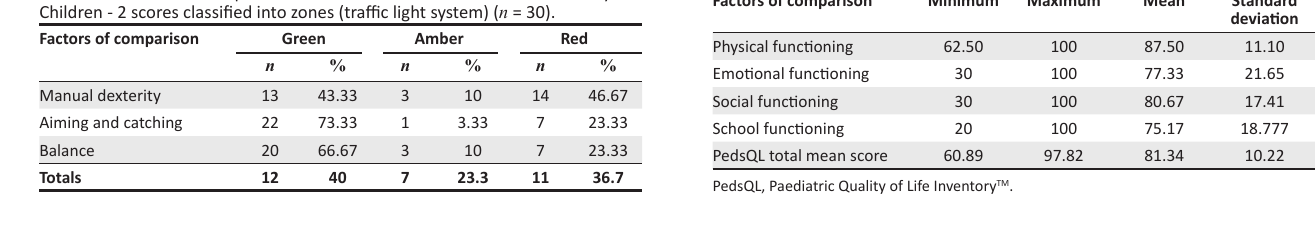
TABLE 3: Standing broad jump test scores ( n = 30). Factors of comparison